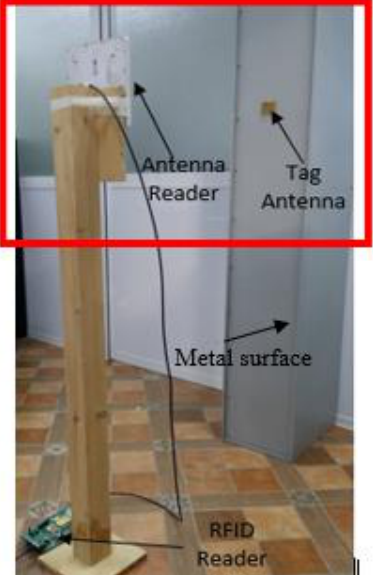
Figure 10: RFID tag read range measurement setup in real